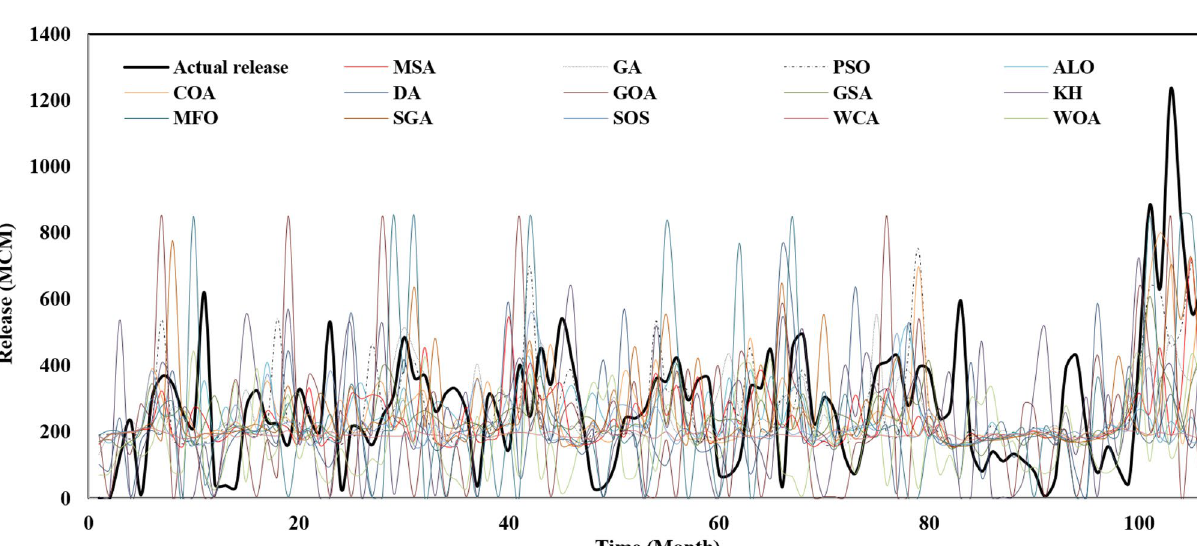
Figure 3. The actual release pattern of Karun-4 hydropower reservoir vs. predicted values by the